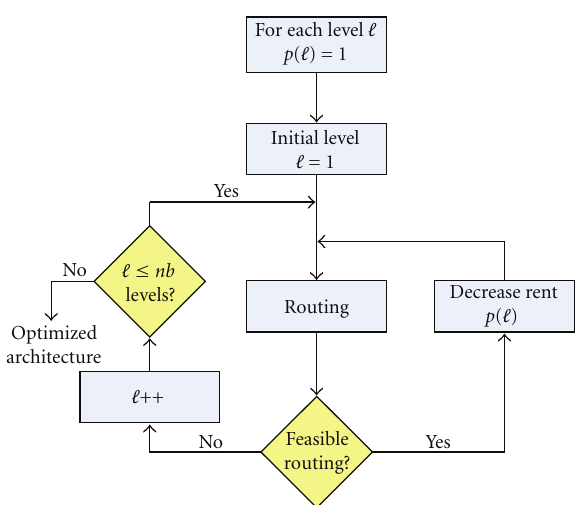
Figure 4: MFPGA architecture optimization flow (bottom-up approach).